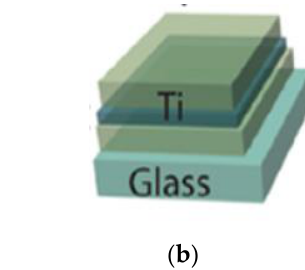
Figure 15. Combination of PDMS layers with thin metallic layers. ( a ) Chromium layer between two PDMS layers. ( b ) Titanium layer sandwiched between PDMS layers. Reproduced with permission from [142].